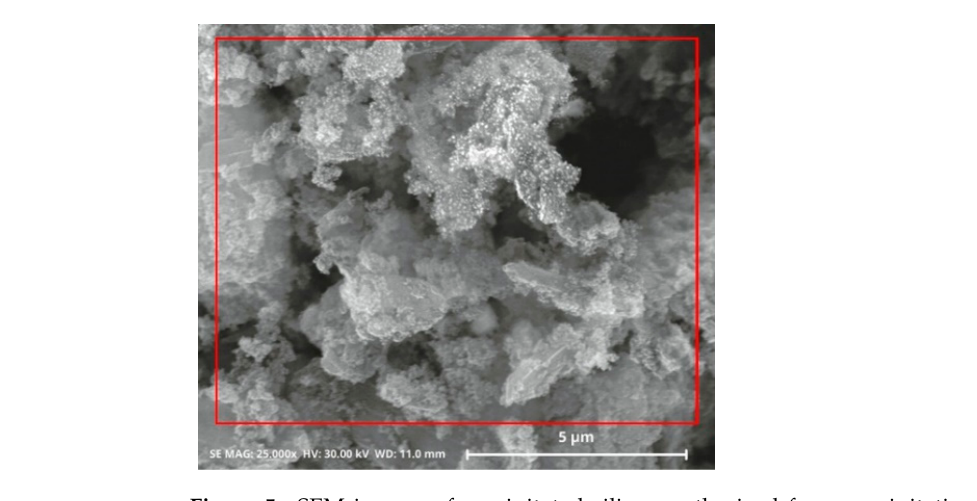
Figure 5. SEM images of precipitated silica, synthesized from precipitation with HCl at pH 2, producing non-uniform particle size and fast agglomeration.